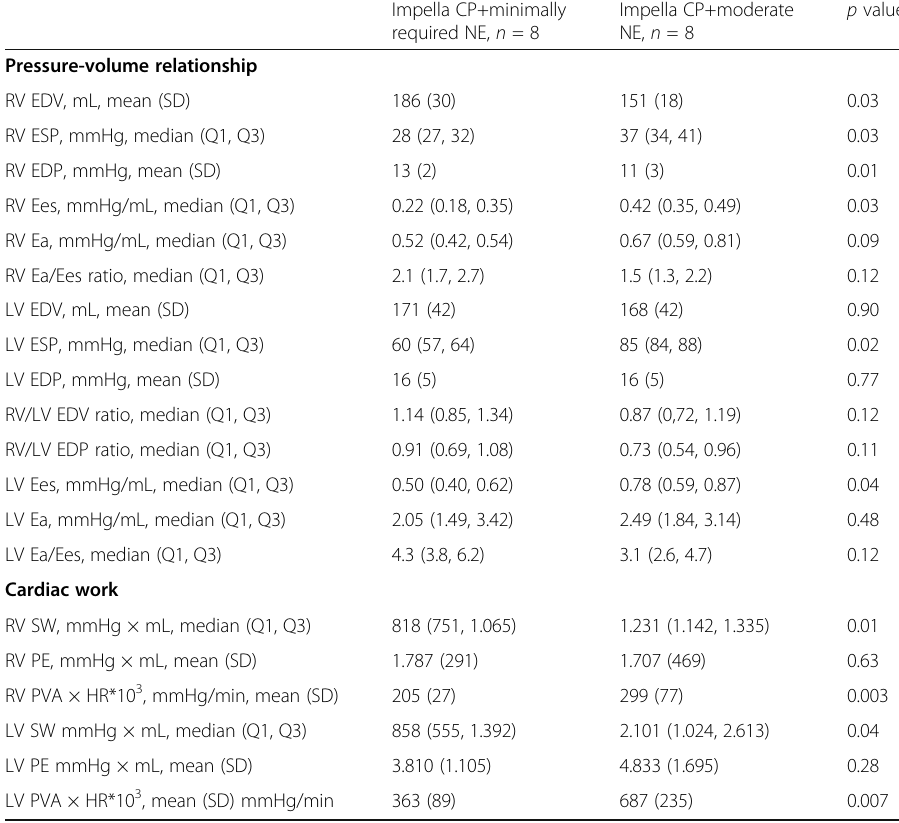
Table 5 Pressure-volume relationship and cardiac work in RV and LV with increased dose of norepinephrine